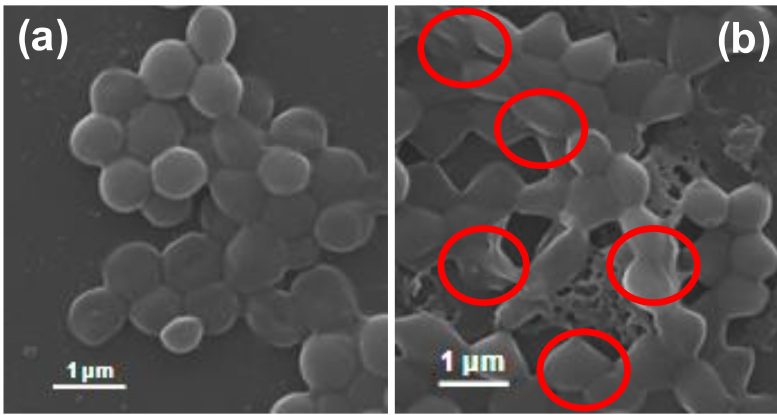
Figure 6. Scanning electron microscopy (SEM) images of S. aureus cells. S. aureus cells of ( a ) untreated and ( b ) treated with AZE3. Red circles indicate membrane regions of S. aureus damaged by